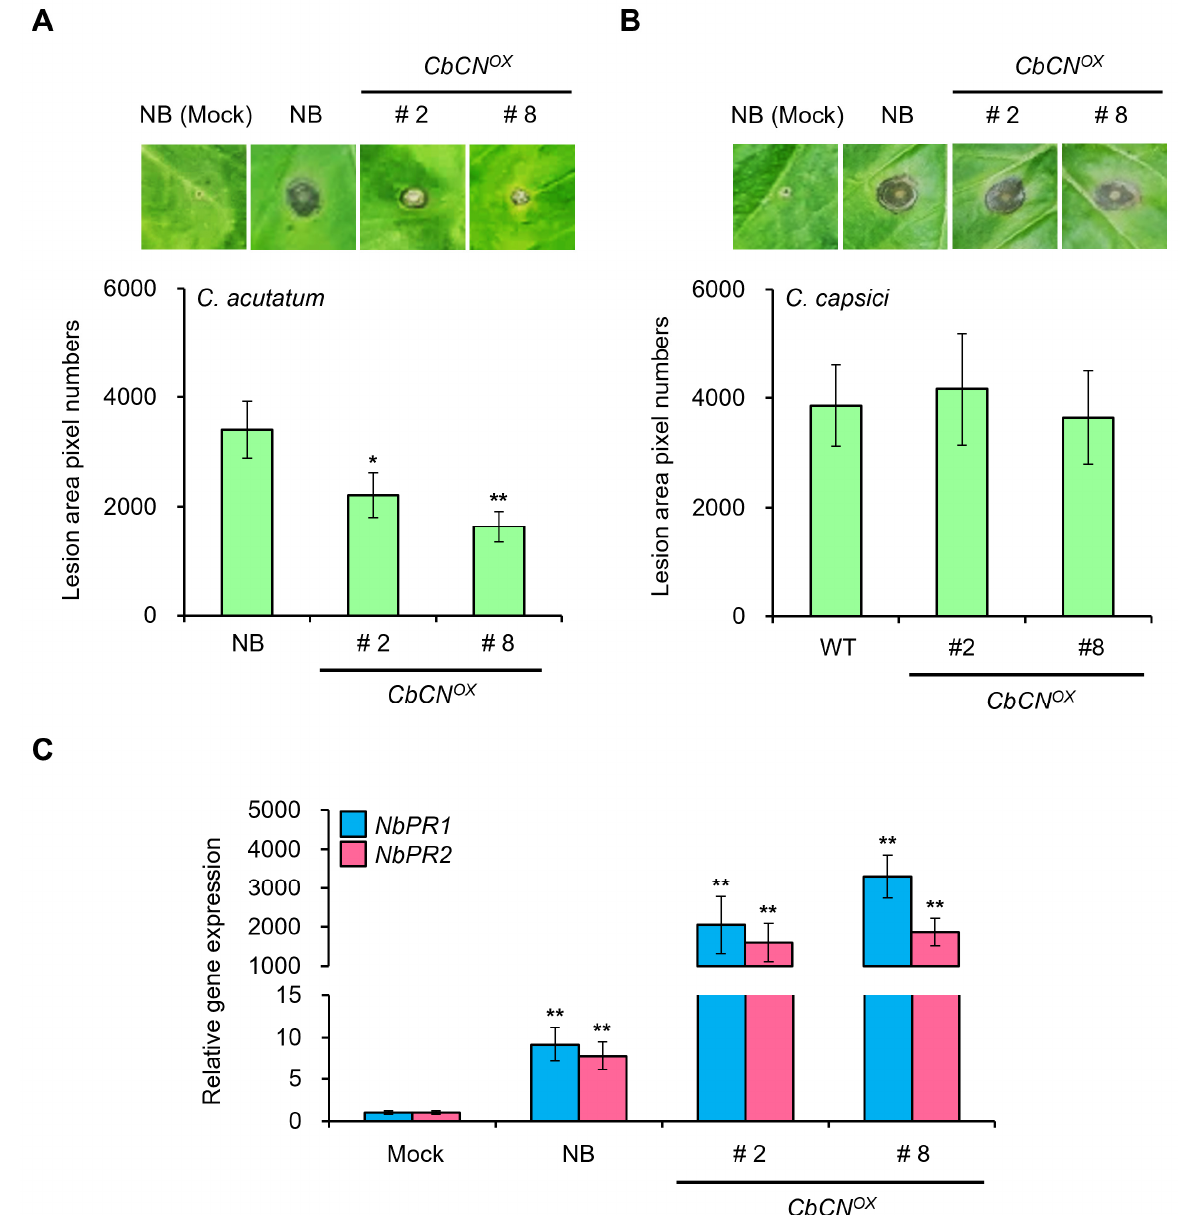
Figure 3. Anthracnose resistance of CbCN -expressing tobacco ( Nicotiana benthamiana ) plants to C. acutatum . ( A , B ) Anthracnose disease resistance assays of CbCN -overexpressing transgenic plants. Four-week-old CbCN OX and wild-type plants were inoculated with C. acutatum ( A ) and C. capsici ( B ) for the disease resistance assays, respectively. Images were captured at 6 days after inoculation and quantitative measurements of the disease area were obtained using the image-based plant disease phenotyping method. Values are expressed as means ± SDs. Asterisks indicate values statistically different from those of controls (* p < 0.05). ( C ) Analysis of the expression of NbPR1 and NbPR2 in CbCN OX plants using RT-qPCR. NbActin served as a control. Values are expressed as means ± SDs. Asterisks indicate values statistically different from those of controls (** p < 0.01). All experiments were repeated at least three times and they generated similar results. Taken together, these results indicated that CbCN is required to upregulate defense genes such as PR1, PR2, and NPR1 in chili